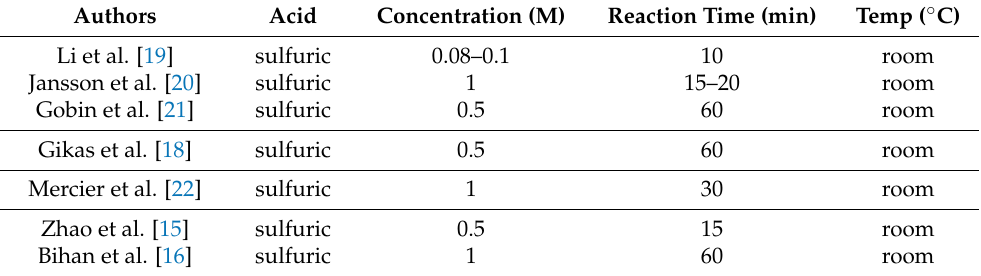
Table 1. The reported methods for the hydrolysis of colistimethate sodium (CMS) to colistin (CS) in plasma. Acid Concentration